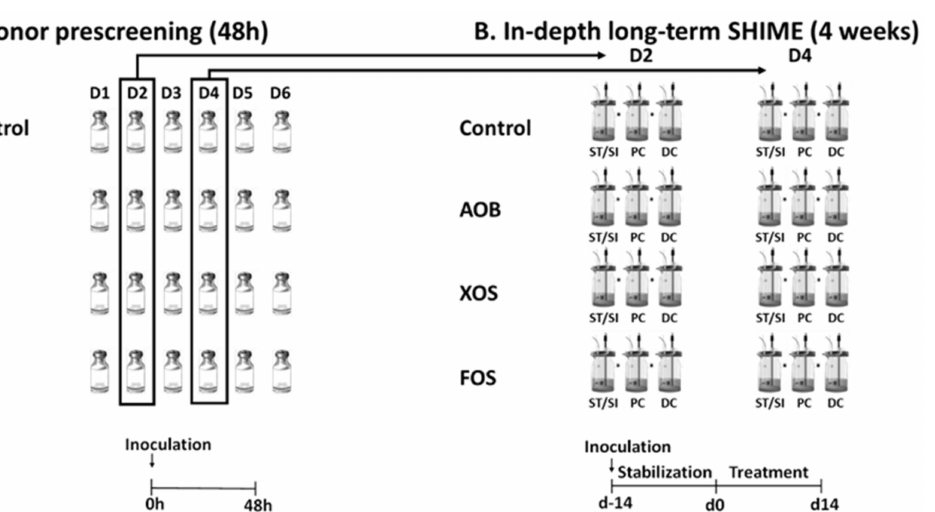
Figure 1. Schematic representation of the experimental set up: ( A ) Short-term incubations (part 1) to assess interindividual variability, using fecal samples from six donors D1–D6 (48 h); ( B ) Long-term SHIME ® study (part 2) using the selected fecal samples (D2 and D4) from the screening of two donors (4 weeks). AOB = antioxidant blend; XOS = xylooligosaccharides; FOS = fructo-oligosaccharides; SFCA = short-chain fatty acid; ST/SI = stomach/small intestine; PC = proximal colon; DC = distal colon; SHIME ® = simulator of the human intestinal microbial